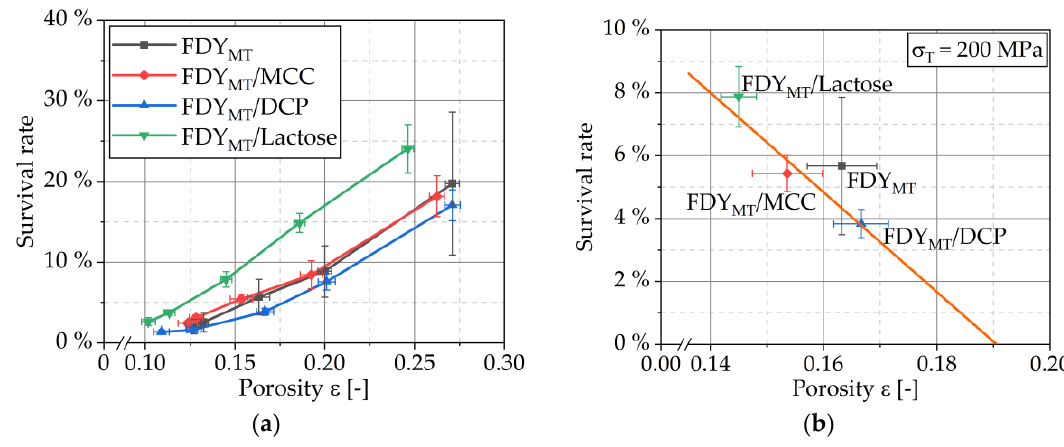
Figure 8. Survival rates depending on porosity for formulations of pure FDY MT and FDY MT mixed with MCC, DCP and lactose compressed with various stresses ( a ) and selectively magnified for 200 MPa ( b ), respectively. Symbols represent means and error bars standard deviation; n = 3.